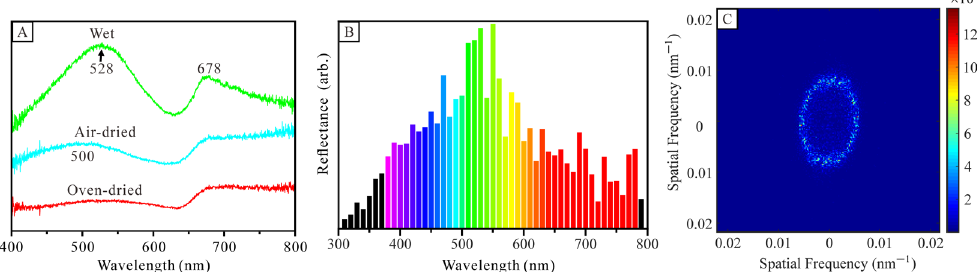
Figure 6. ( A ) Measured reflectance spectrum of cross-sectional fractured shell along line a-a’ in Figure 1A. ( B ) The predicted reflectance spectrum. ( C ) 2D Fourier power spectra of binary micrographs of nearly circular imprints.